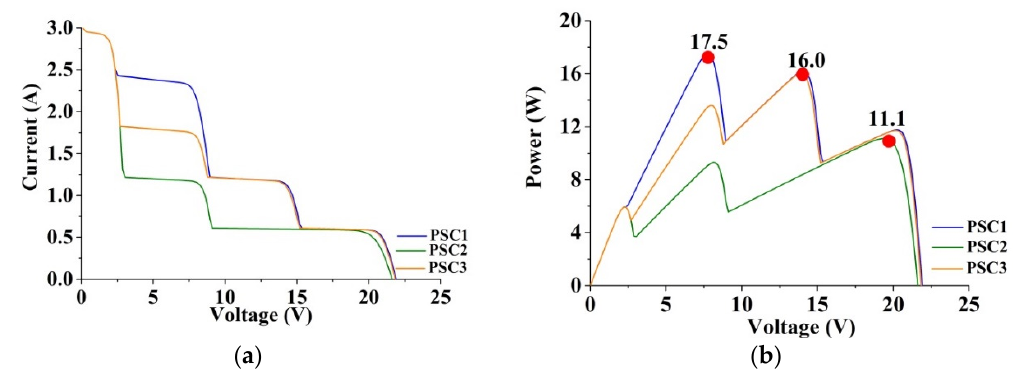
Figure 8. ( a ) I-V ( b ) P-V curves under three different partial shading conditions.